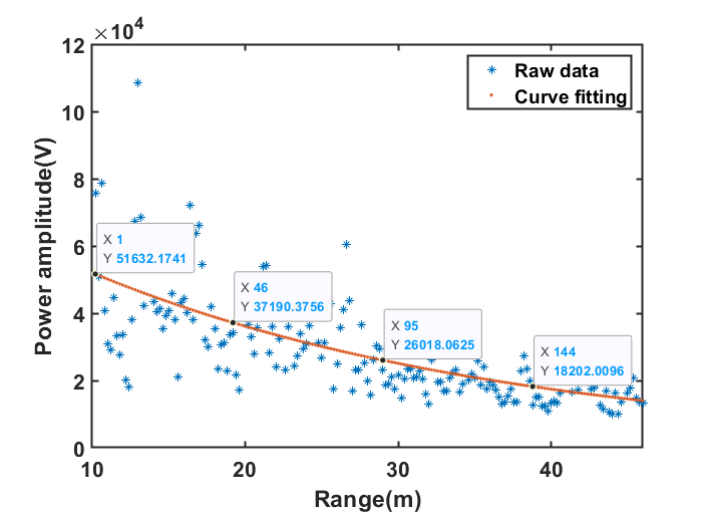
Figure 25. RAM division